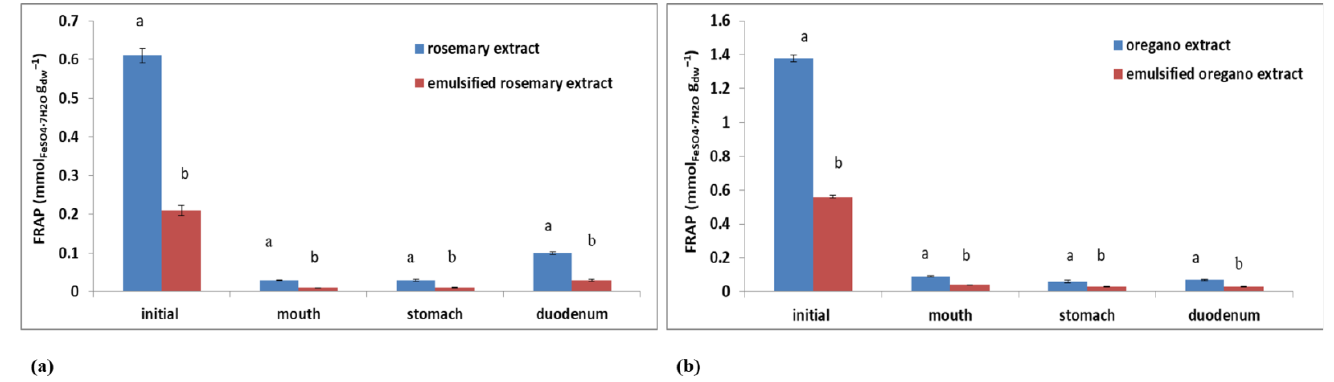
Figure 8. Changes in the antioxidant activity (DPPH) of plant extracts and oil-in-water emulsions containing extract during in vitro digestion for ( a ) rosemary and ( b ) oregano. Different letters above the columns represent significant differences at p < 0.05.